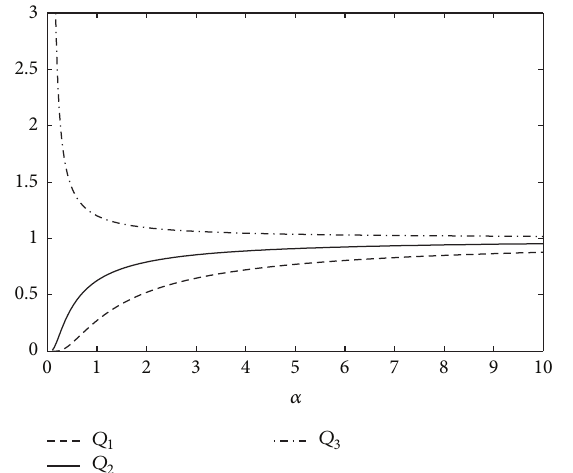
Figure 5: The quartiles of TN (𝛼,𝛽) as functions of 𝛼 , when 𝛽 = 1 .